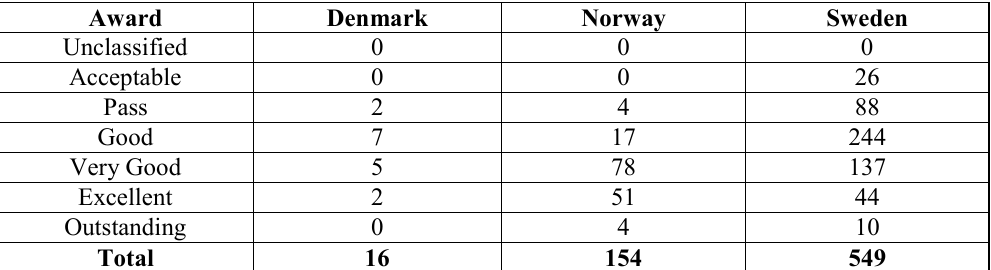
Table 2. BREEAM Projects (Developed by authors)